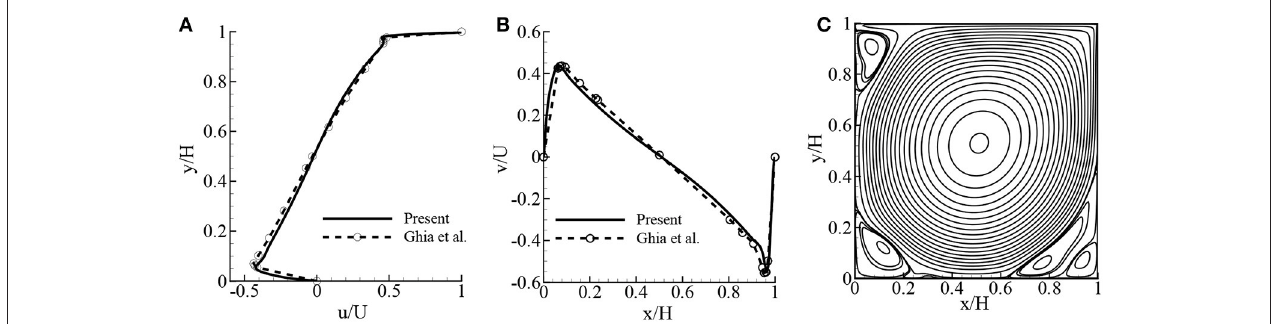
FIGURE 5 | Comparison of the lid-driven cavity flow with the results of Ghia et al. (1982) (finite difference solutions): (A) u / U - velocity at mid x / H , (B) v / U - velocity at mid y / H , and (C) streamlines while Re 10,000 after 2,000,000 iterations. =